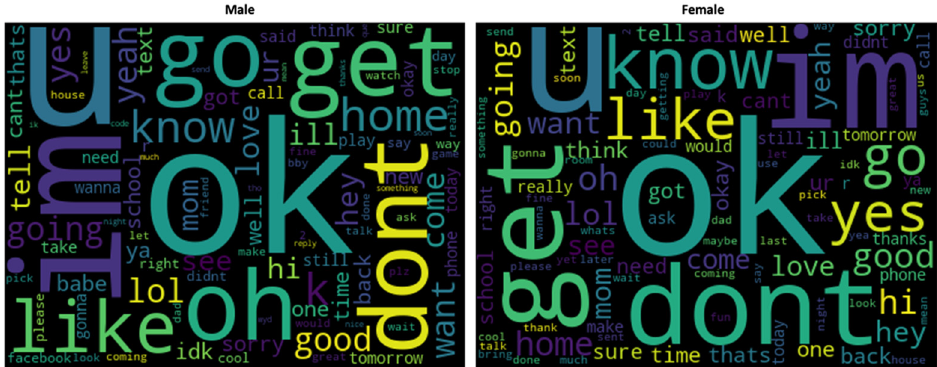
Figure 8. Term analysis in cyberbullying data Male vs. Female.